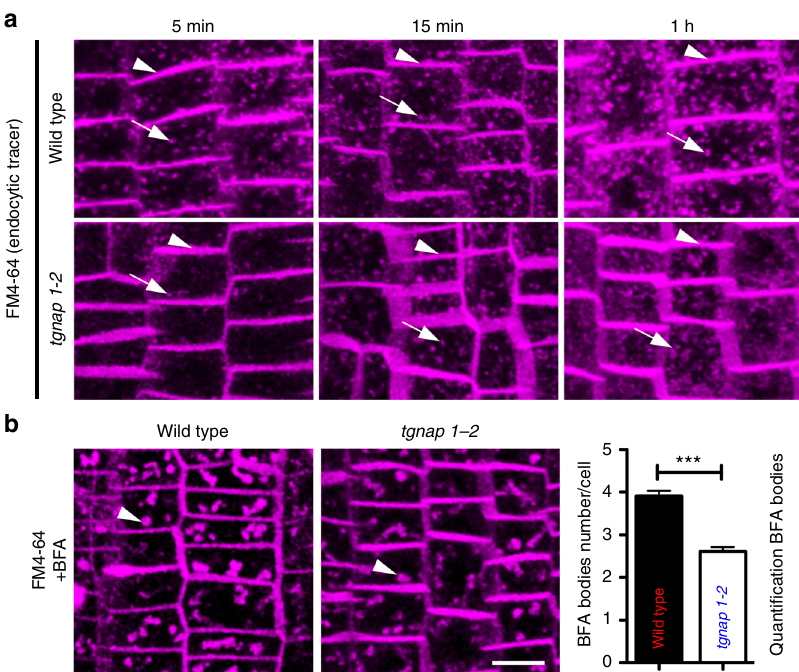
Fig. 2 TGNap1 is required for endocytosis homeostasis. a Max intensity projections of serial confocal images (depth: 35 µ m) of WT and tgnap1 – 2 primary root cells at 5 min, 15 min, and 1 h after labeling with FM4 – 64. Arrowheads: FM4 – 64 at the PM; arrows: FM4 – 64 at the endosomes. b Confocal images of BFA bodies (arrowheads) in WT and tgnap1 – 2 cells labeled with FM4 – 64 for 5 min. Graph indicates the number of BFA bodies/cell. WT cells ( n = 105), tgnap1 – 2 cells ( n = 125). Scale bars = 5 µ m. Error bars indicate S.E.M; Student t -test was applied, p -values are represented by asterisks when signi fi cantly different from the corresponding control: **0.001 > p < 0.01; *** p < 0.001. Source data are provided as a Source Data fi